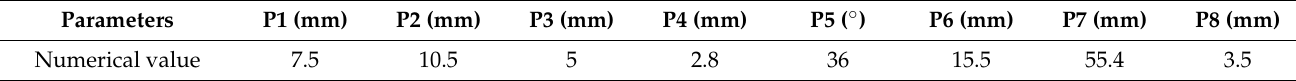
Table 3. Structural dimension parameters of the stator.